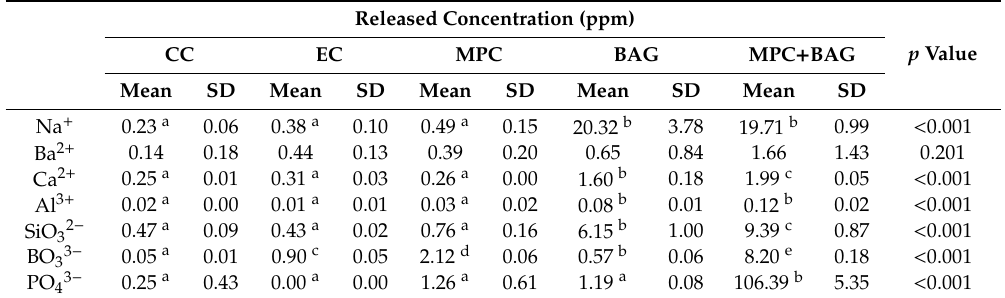
Table 1. Released concentrations of Na + , Ba 2 + , Ca 2 + , Al 3 + , SiO 32 − , BO 33 − , and PO 43 − ions from the samples *.